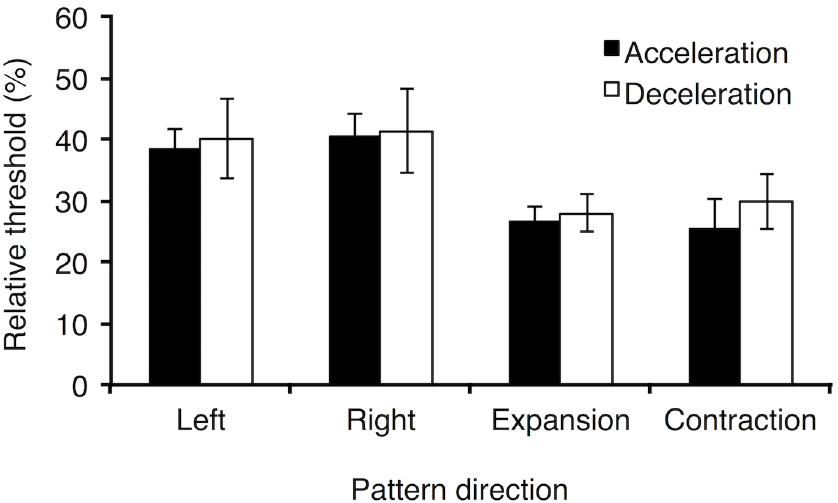
Fig 2. Mean relative acceleration and deceleration detection thresholds (%) as a function of pattern direction. Error bars are ± 1 SEM .